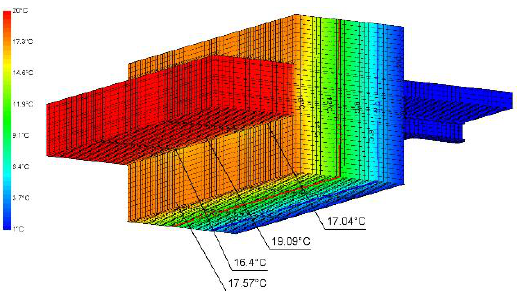
Figure 15. Internal surface temperature distribution field on the wall and deck—bottom view.